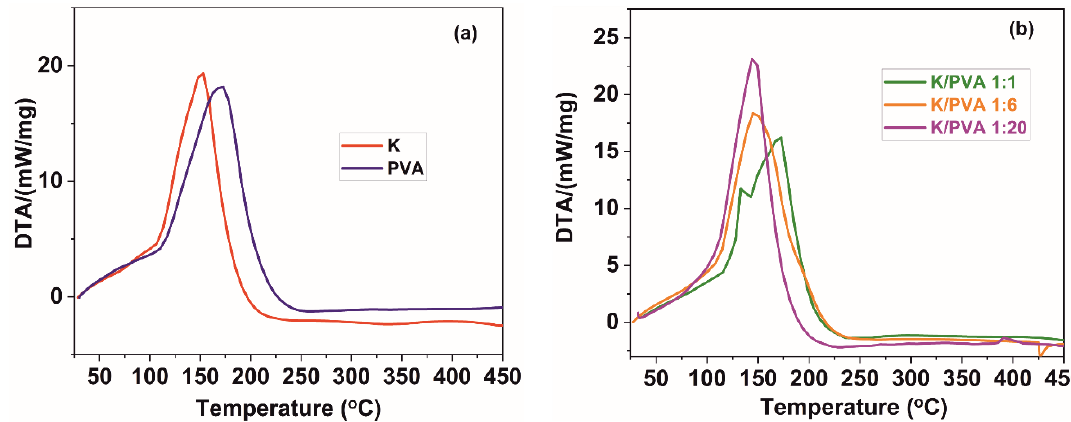
Figure 6. DTA thermograms of ( a ) PVA and CAR; ( b ) PVA/CAR mixtures.